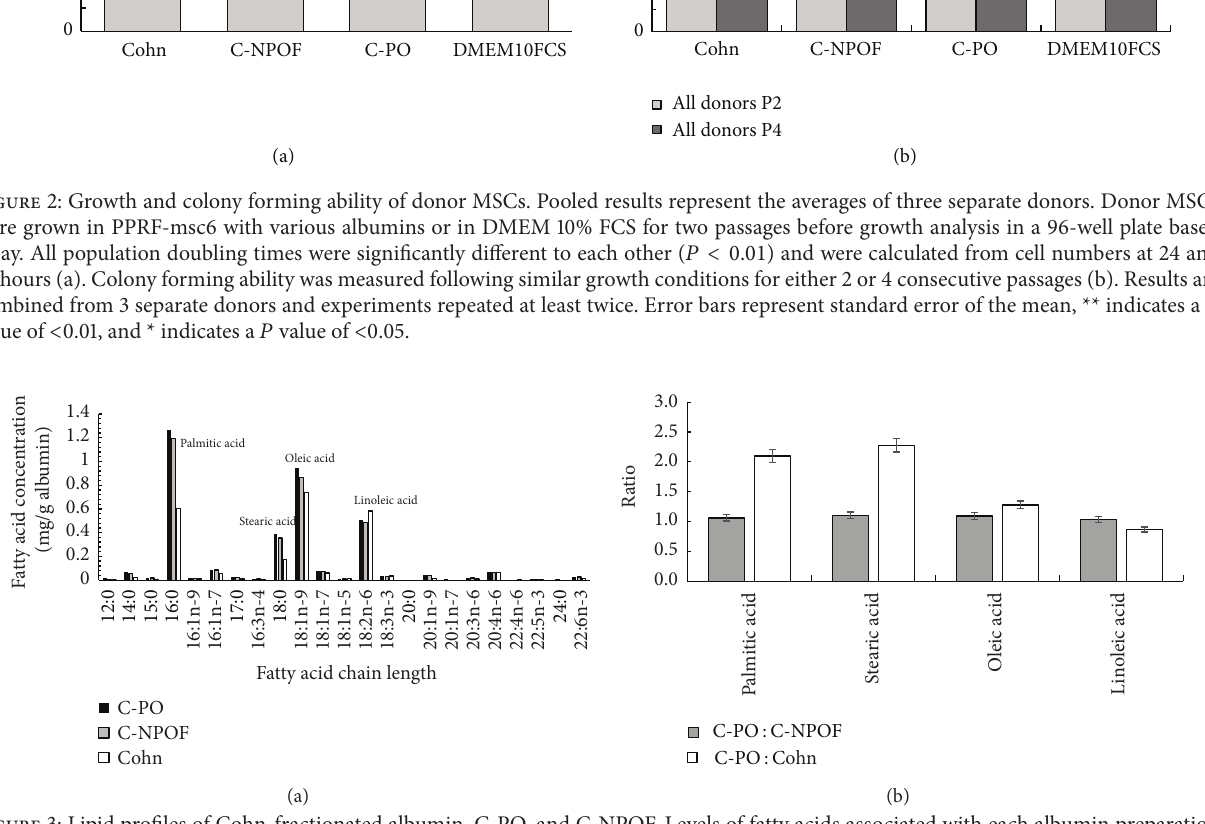
Figure 3: Lipid profiles of Cohn-fractionated albumin, C-PO, and C-NPOF. Levels of fatty acids associated with each albumin preparation per gram of albumin plotted against the estimated chain length following gas chromatography. Major peaks identified with common names (a). Ratios of significant fatty acids C-PO:C-NPOF and C-PO: Cohn demonstrate the similarity of C-PO and C-NPOF and the dissimilarity of C-PO and Cohn